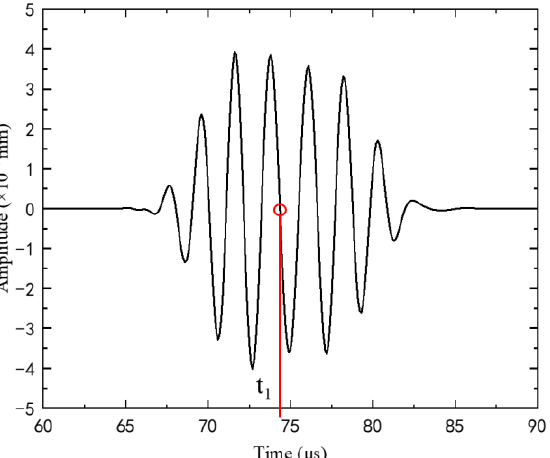
Figure 34. The central zero point of direct wave packet (Time coordinate: t 1 ).